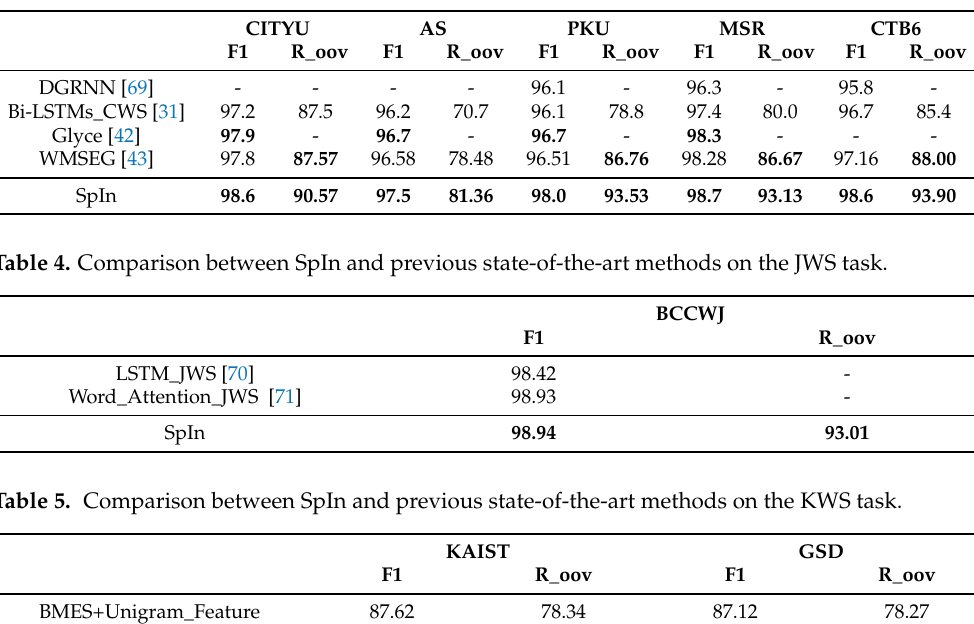
Table 3. Comparisons between SpIn and previous state-of-the-art results on the CWS task.